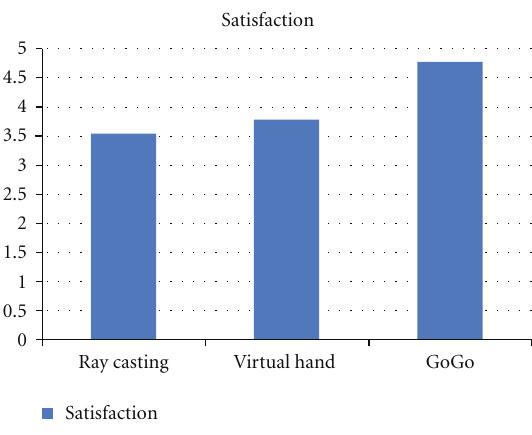
Figure 11: Mean di ff erence in the